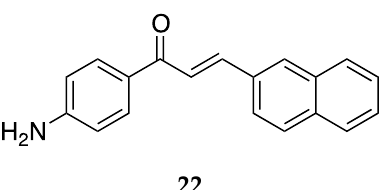
Figure 18. Chemical structure of 4-aminochalcone derivate with a naphthalene ring.